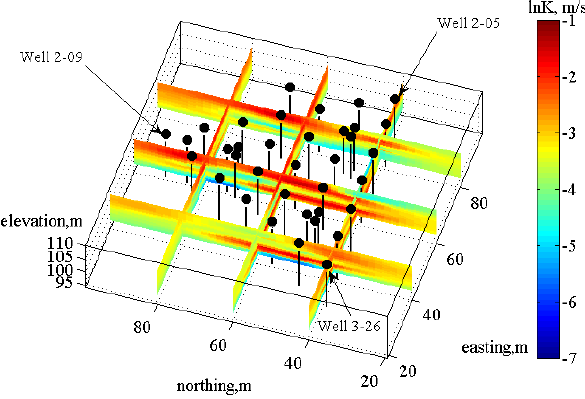
Fig. 10. 3-D mean ln K field in the saturated portion of the Han- ford formation. The black dots and lines represent the well loca- tions. The reference point of local coordinates is at (594164m, 115976m) in the Hanford